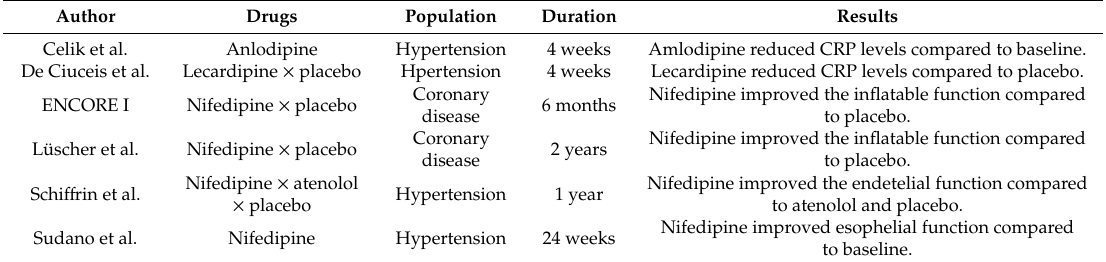
Table 2. Randomized clinical trials showing the e ff ect of treatment with calcium channel blockers on serum C-reactive protein levels and endothelial